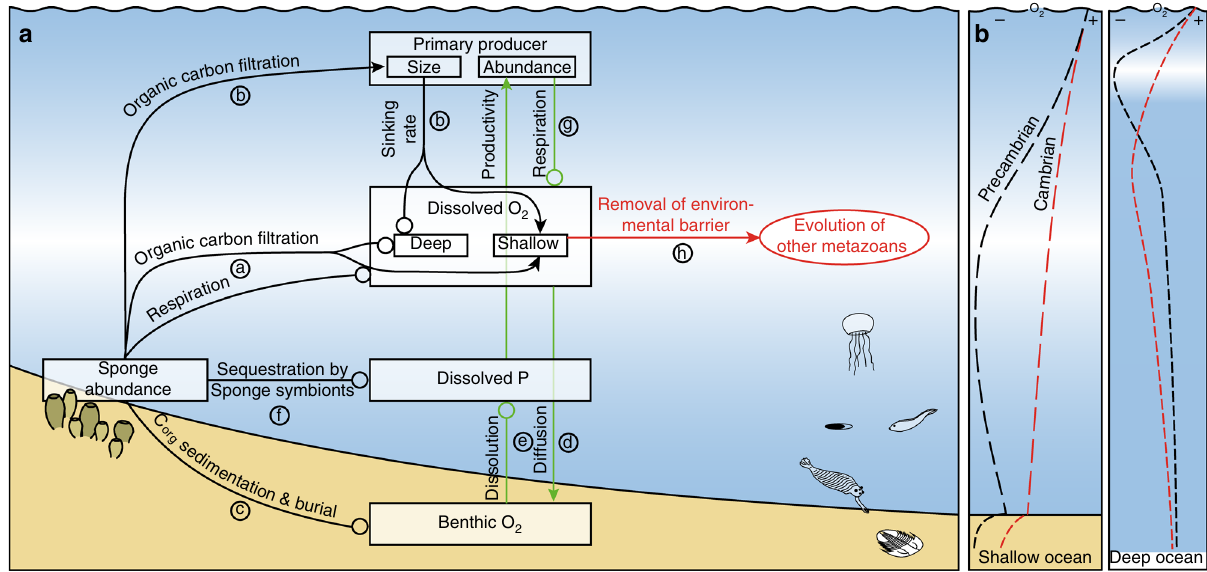
Fig. 4 Couplings in the Late Neoproterozoic to Cambrian marine ecosystem and their effects on the oxygen concentration in the water column. a Effects resulting from the expansion of sponges. Processes a – h are denoted by arrows and are detailed in the text. Arrows denote positive couplings (enhancing mechanisms) and circles negative couplings (inhibiting mechanisms). b With expansion of sponges the oxygen minimum zone shifted towards greater water depth, increasing the benthic oxygen inventory at the continental